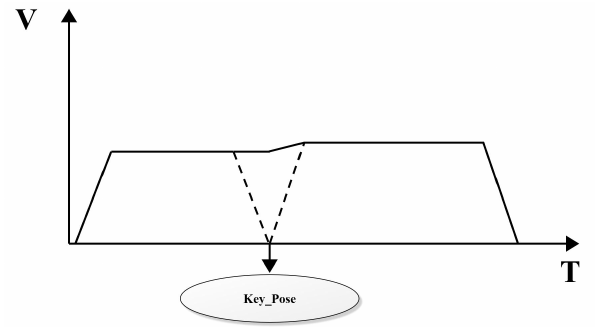
Figure 7. Improved of continuous motion